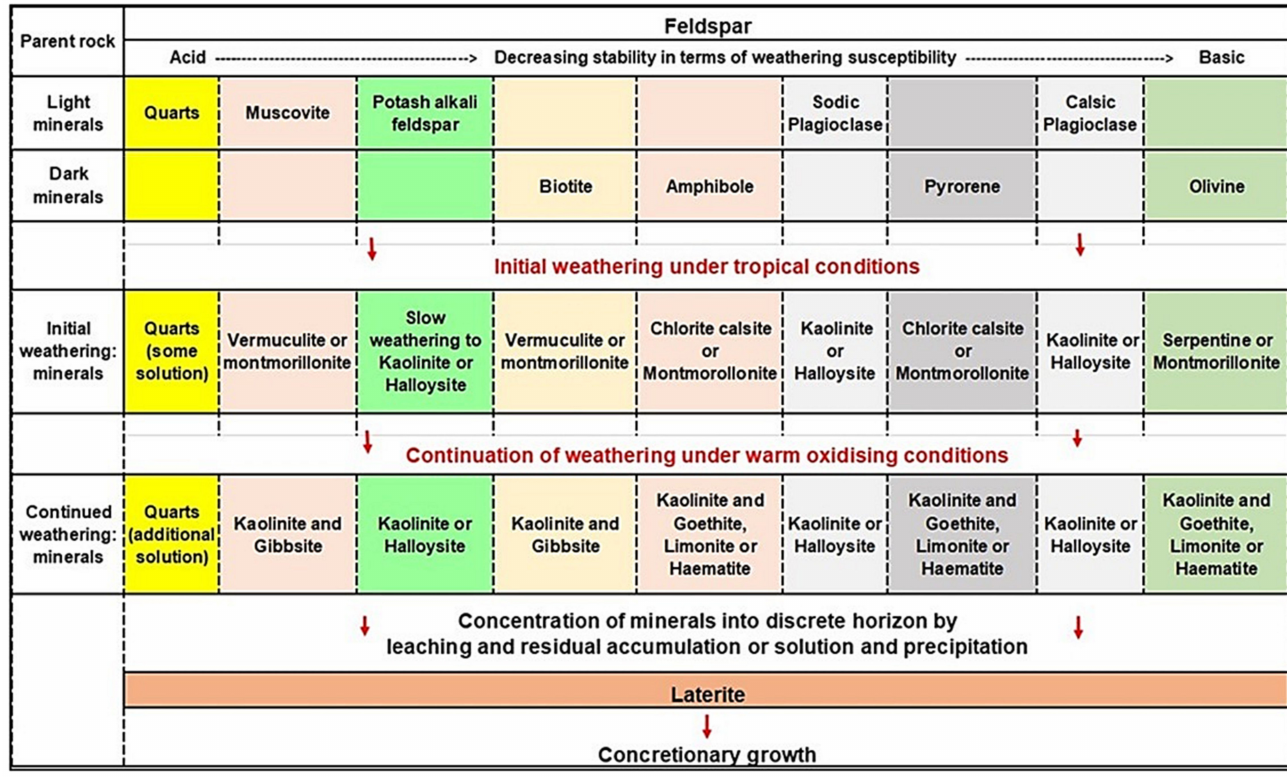
Figure 9. Chemical decomposition through weathering and the formation of secondary minerals through the transformation of primary rock formations (recreated from